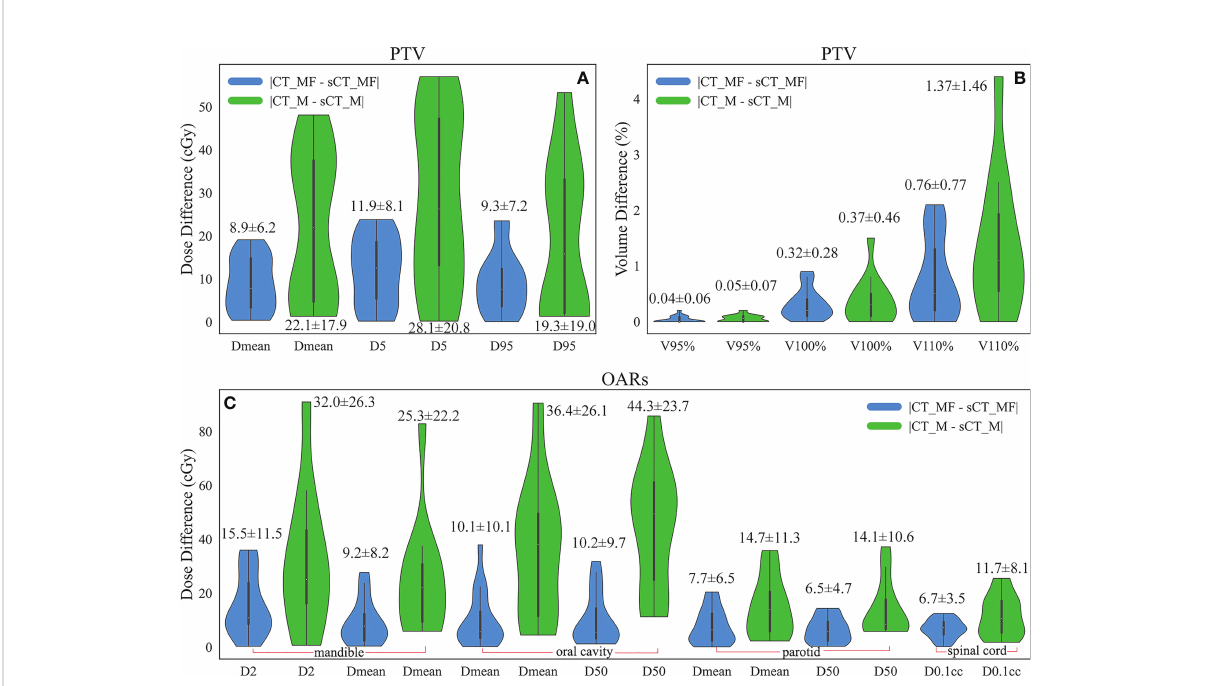
FIGURE 6 Comparison of the absolute dose errors for the PTV and OARs. (A) Dose difference (cGy) of the PTV. (B) Volume difference (%) of the PTV. (C) Dose difference (cGy) of the OARs. The numbers marked in the fi gure are the average ± standard deviation. Compared with metal-free cases, the average and standard deviation of the dose differences for the PTV and OARs doubled for cases with metal artifacts.